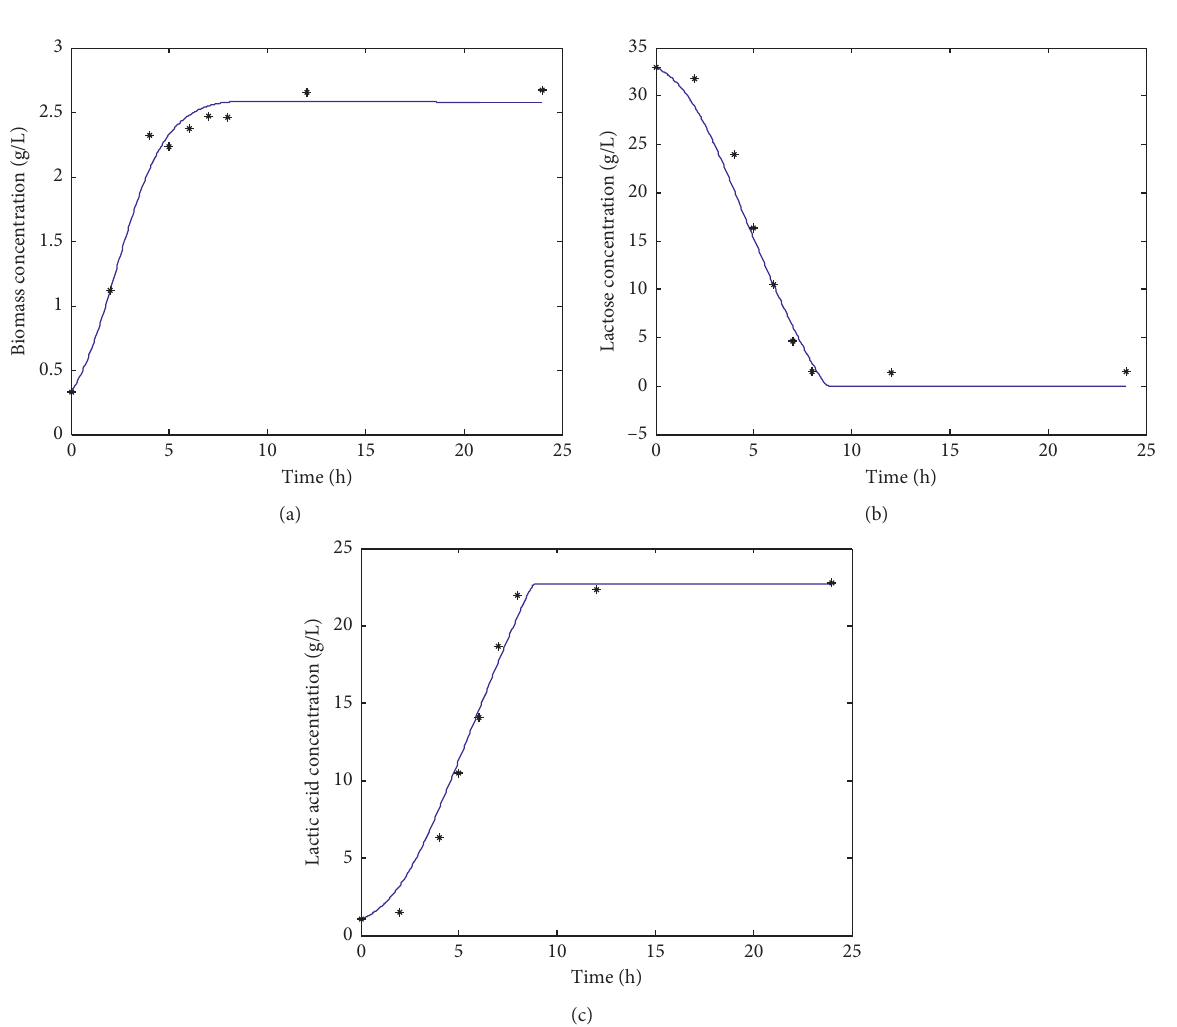
Figure 3: Experimental data (points) and simulation (lines) of biomass (a), lactose (b), and lactic acid (c) concentrations of 20L bioreactor batch culture of Enterococcus faecalis SLT13 on hydrolyzed cheese